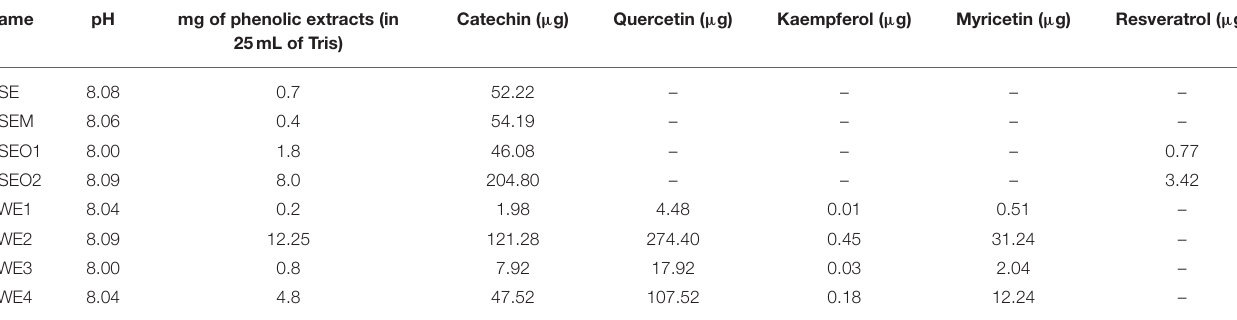
TABLE 2 | Concentration, pH, and composition of single wine flavonoids included in the polyphenolic extract solutions prepared in Tris 50mM, pH =